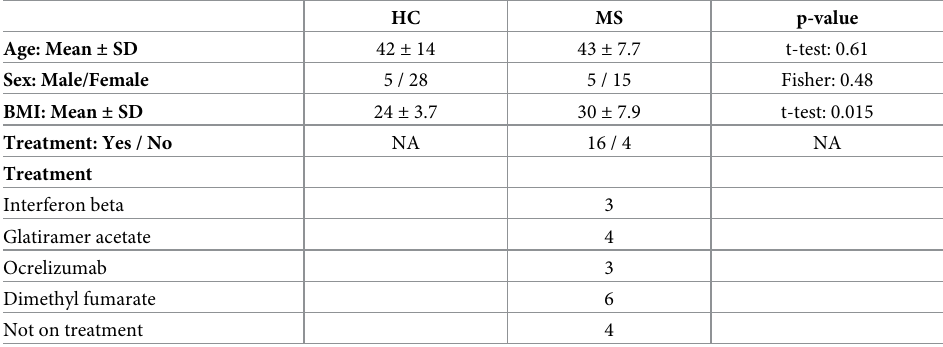
Table 1. Biometric and MS patient treatment